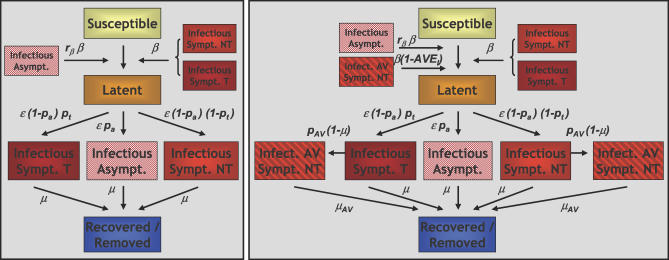
Flow Diagrams of the Transmission ModelsThe compartmentalization schemes adopted in the baseline scenario (left) and in the presence of intervention with the use of therapeutic AV treatment (right) are shown. “Sympt. T” and “Sympt. NT” correspond to infected symptomatic individuals allowed to travel and not allowed to travel, respectively. “Infect. AV” indicates infectious individuals under AV treatment, who are therefore not allowed to travel (NT).